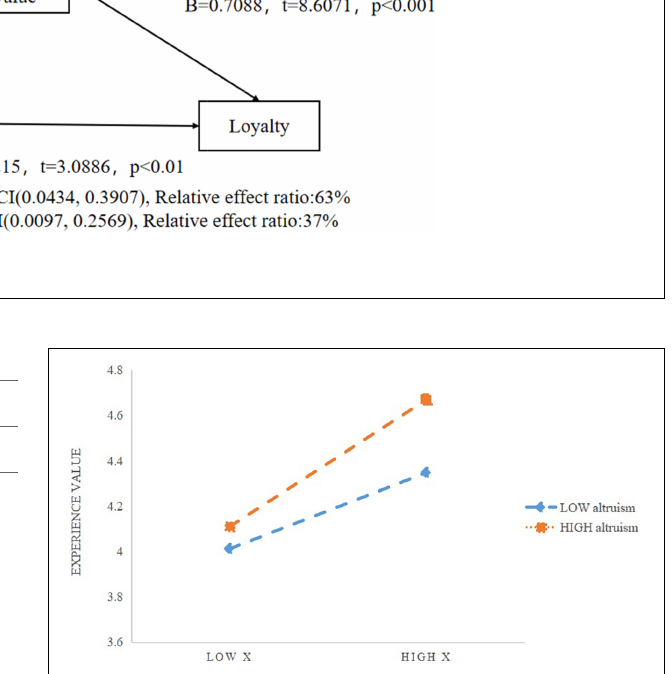
FIGURE 5 | Simple slope analysis of